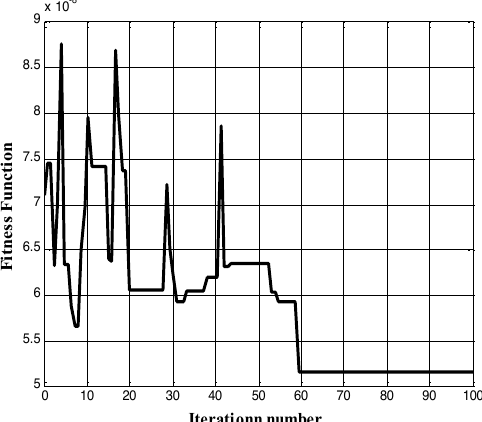
Figure 6: Objective function variation with number of iterations.